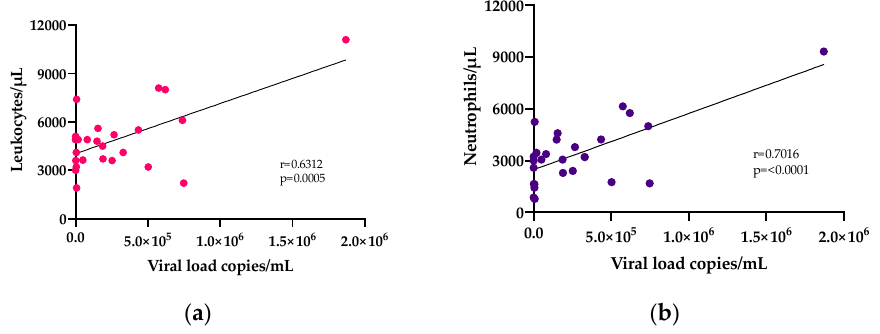
Figure 3. Correlation analysis of viral load with white blood cells. ( a ) Leukocytes vs. viremia, ( b ) Neutrophils vs. viremia.